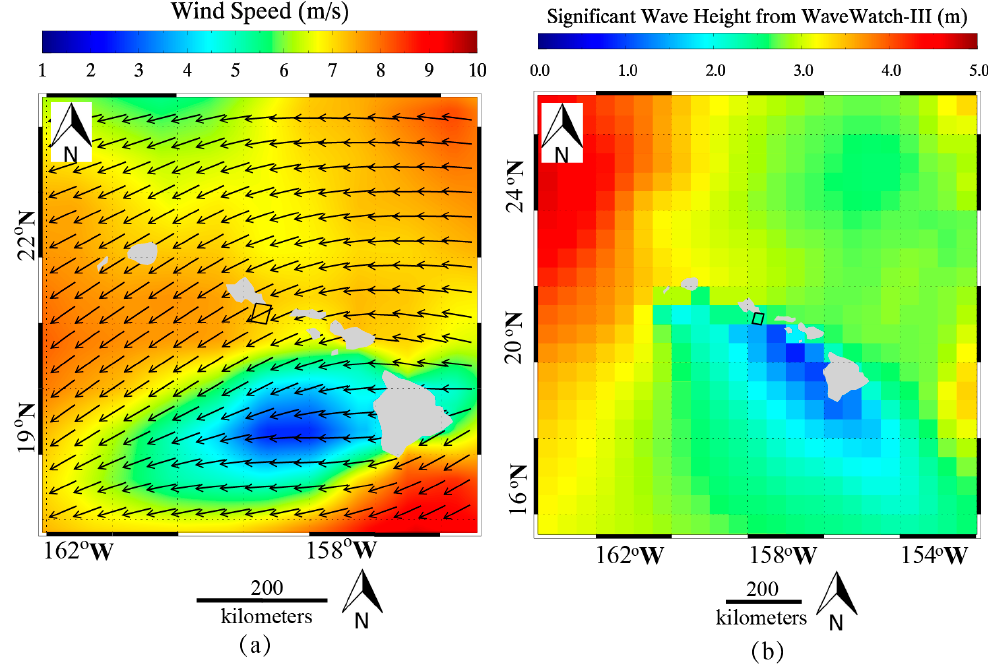
Figure 2. ( a ) European Centre for Medium-Range Weather Forecasts (ECMWF) wind field at 18:00 UTC and; ( b ) Significant wave height (SWH) field from WaveWatch-III at 18:00 UTC on 20 December 2016. The black rectangle represents the coverage of GF-3 synthetic aperture radar (SAR) image in Figure 1.